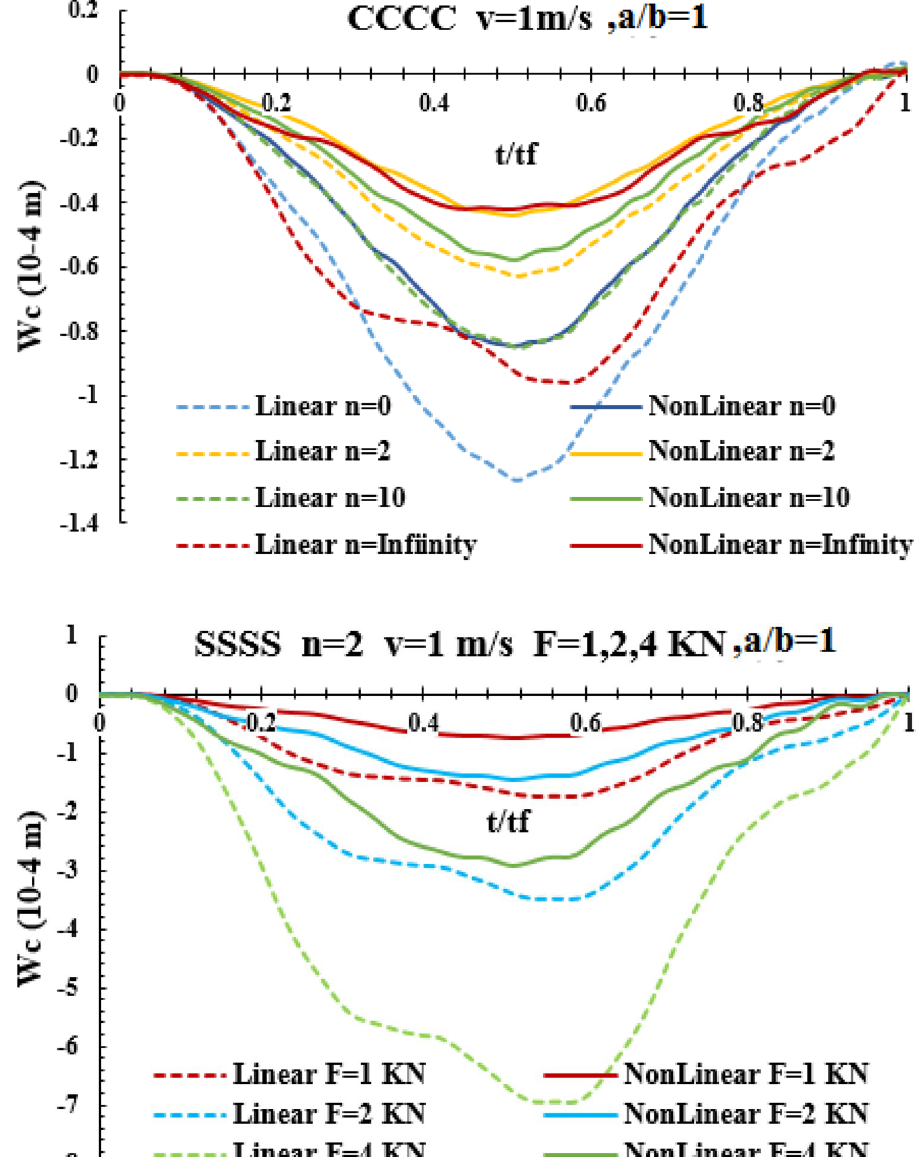
Fig. 13 The effect of material gradient index on deflection history of center-point of the plate (CCCC boundary condi- tion)